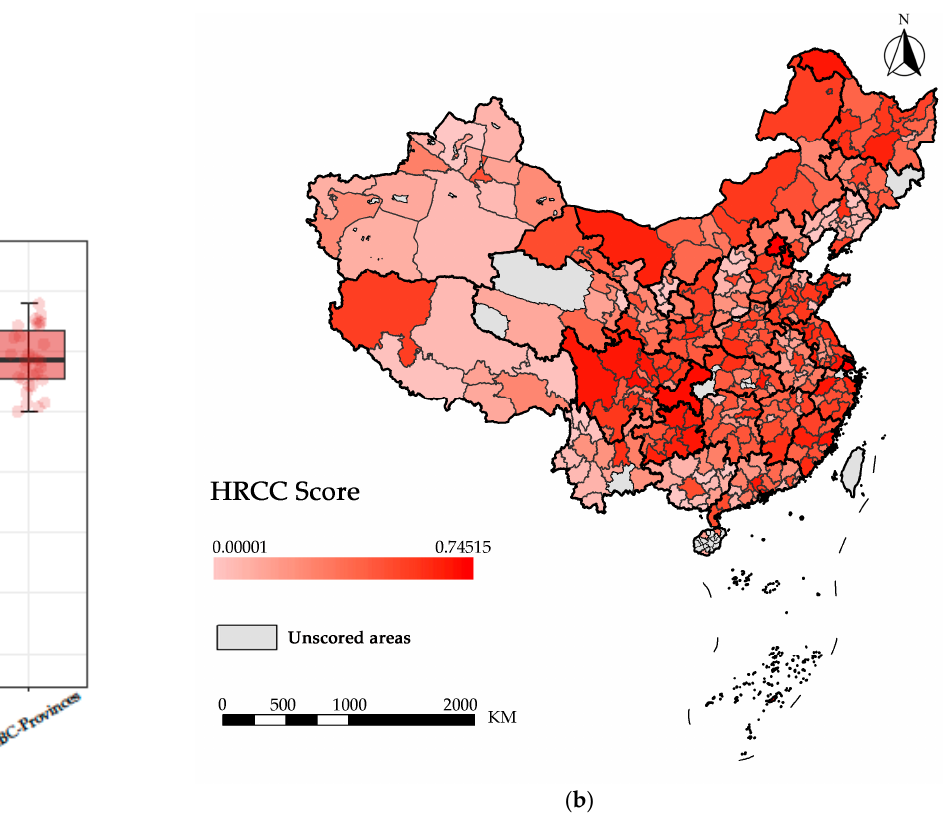
Figure 5. HRCC scores and comparisons: ( a ) provincial and municipal HRCC score statistics; ( b ) the HRCCs of 333 cities in mainland China.